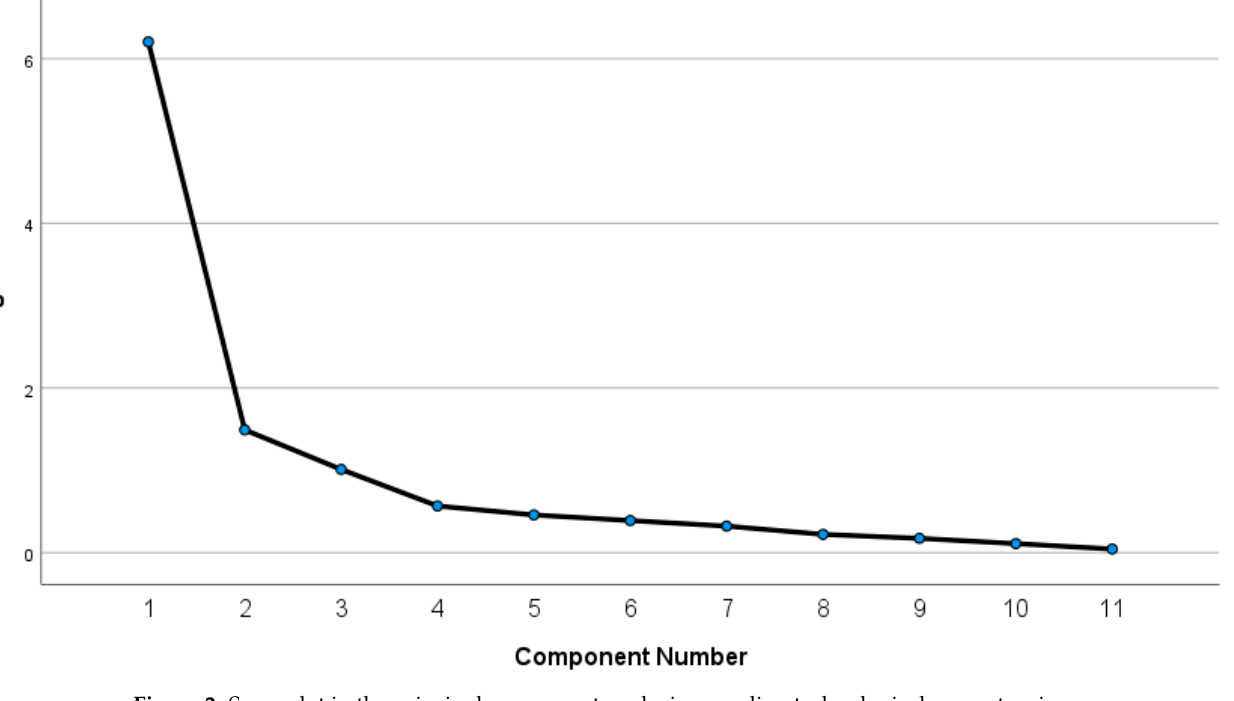
Figure 2. Scree plot in the principal component analysis regarding technological competencies. Based on the Kaiser criterion, three components were extracted. Table 4 presents fac- tor loadings in a pattern matrix. The values lower than 0.4 were suppressed for clarity. Table 4. Pattern matrix acquired in the principal component analysis regarding technological com- petencies.